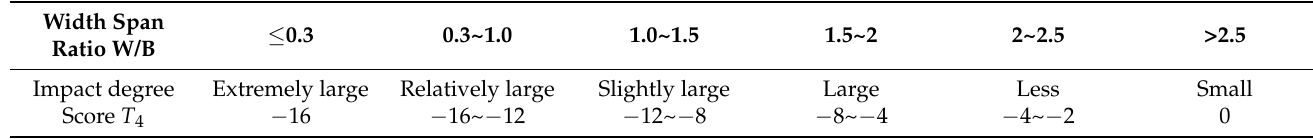
Figure 8. Relationship between the PEEQ max and the width–span ratio of the central area of the middle rock pillar. Table 10. Width–span ratio score of the middle rock pillar.